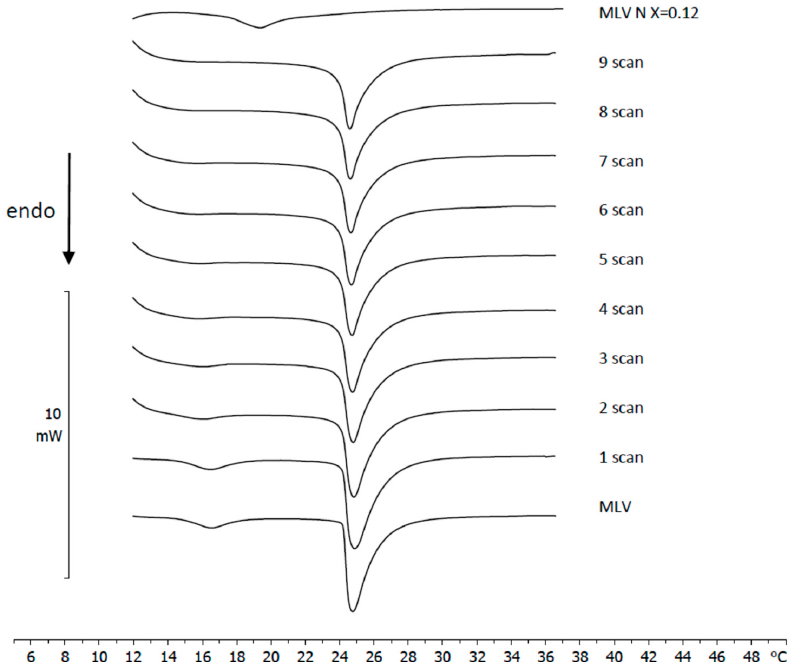
Figure 5. Calorimetric curves, in heating mode, of MLV left in contact with Naringenin (molar fraction 0.12). The calorimetric curves are compared with that of MLV prepared with Naringenin at a 0.12 molar fraction.